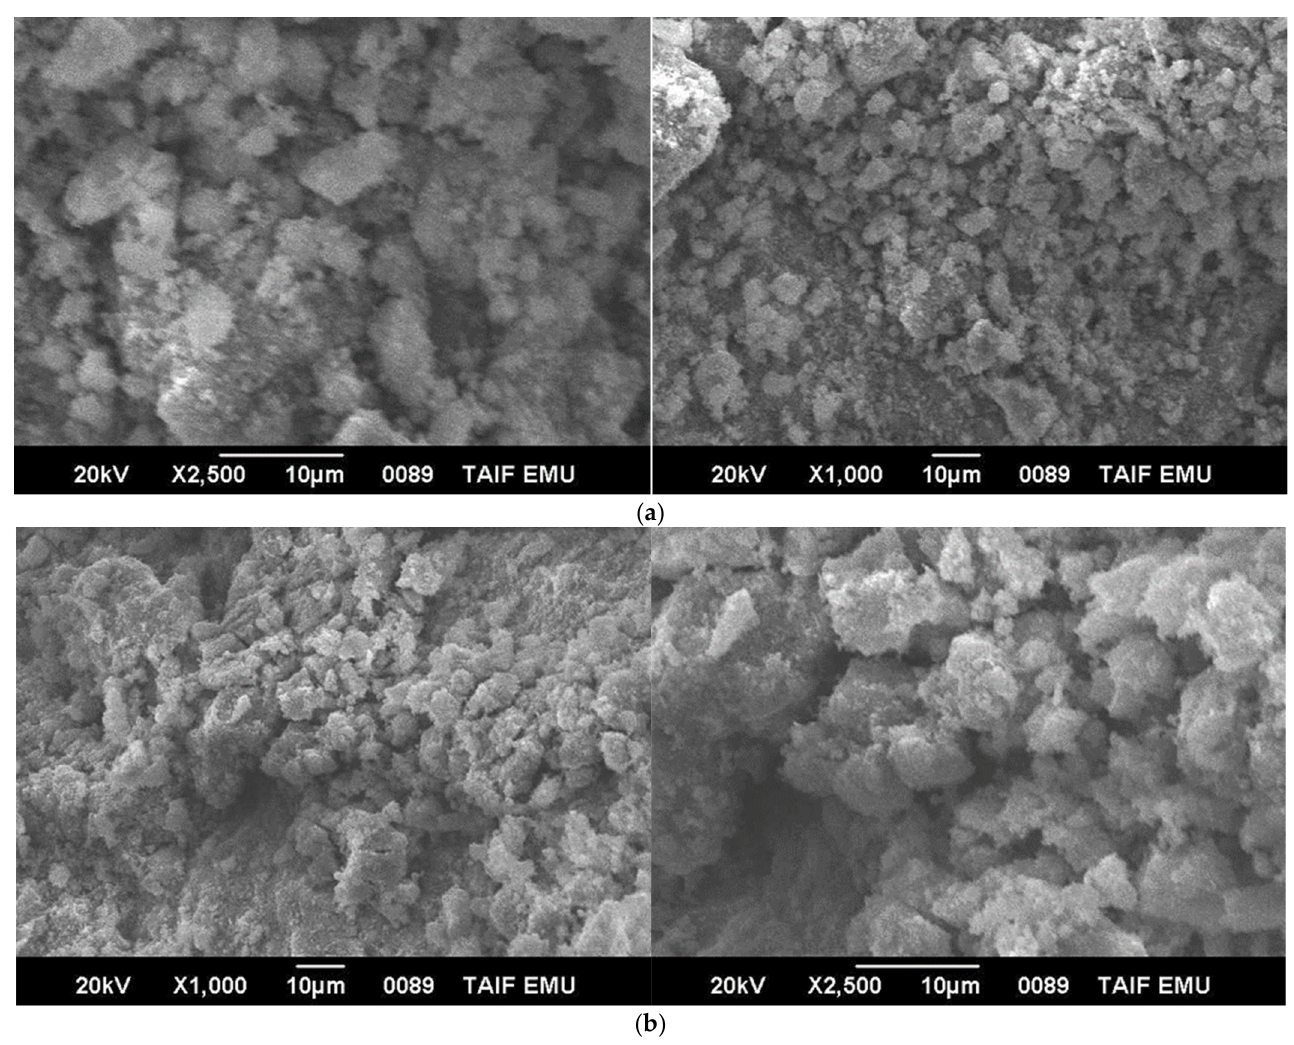
Figure 4. ( a ) SEM micrographs of Solid Mixture A: [Fe(NH 2 CONH 2 ) 6 ]Cl 3 and [Cr(NH 2 CONH 2 ) 6 ]Cl 3 . ( b ) SEM micrographs of Solid Mixture B: [Fe(NH 2 CONH 2 ) 6 ]Cl 3 and [Cr(NH 2 CONH 2 ) 6 ](NO 3 ) 3 .